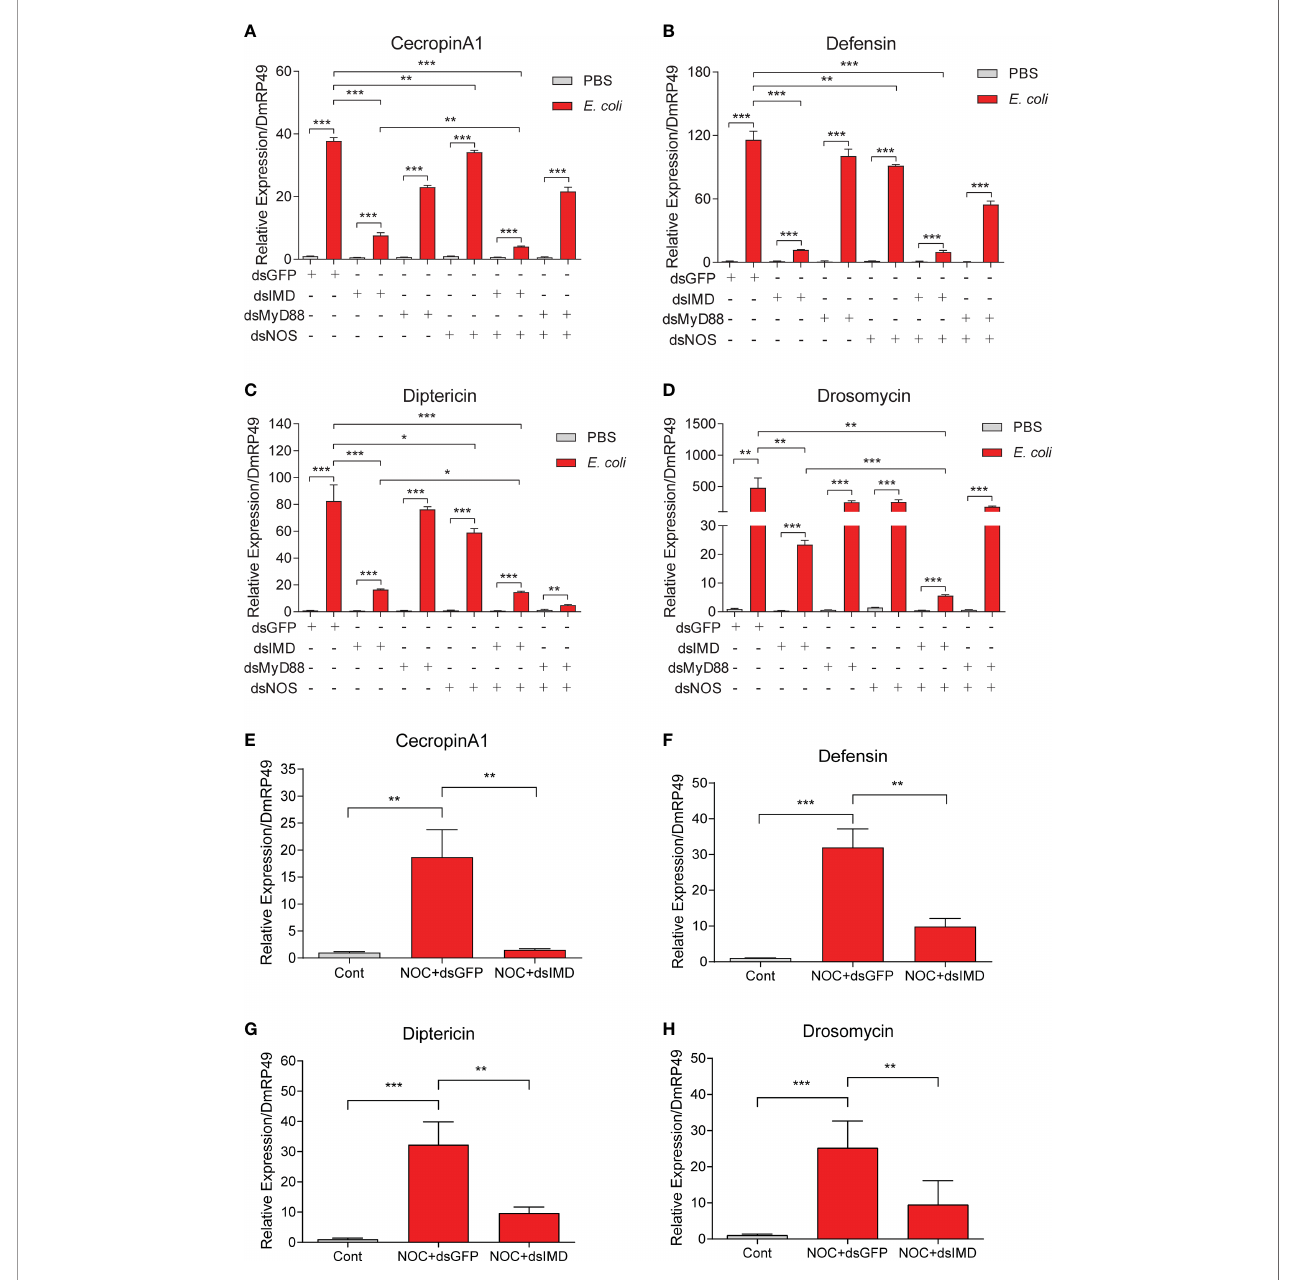
FIGURE 6 | Effects of IMD , MyD88 or NOS knockdown on AMP expression in Drosophila S2 cells. To analyze possible roles of Toll/IMD pathway and NOS in NO- induced AMP expression, RNAi of IMD , MyD88 or NOS was performed in S2 cells for 48 h in advance of the treatment by killed E coli . Transcript levels of Cecropin A1 (A) , Defensin (B) , Diptericin (C) and Drosomycin (D) were analyzed by qPCR. The effects of IMD knockdown on induction of CecropinA1 (E) , Defensin (F) , Diptericin (G) and Drosomycin (H) by the NOC were detected. Student ’ s t-test was used to analyze signi fi cance, * p < 0.05; ** p < 0.01; *** p <